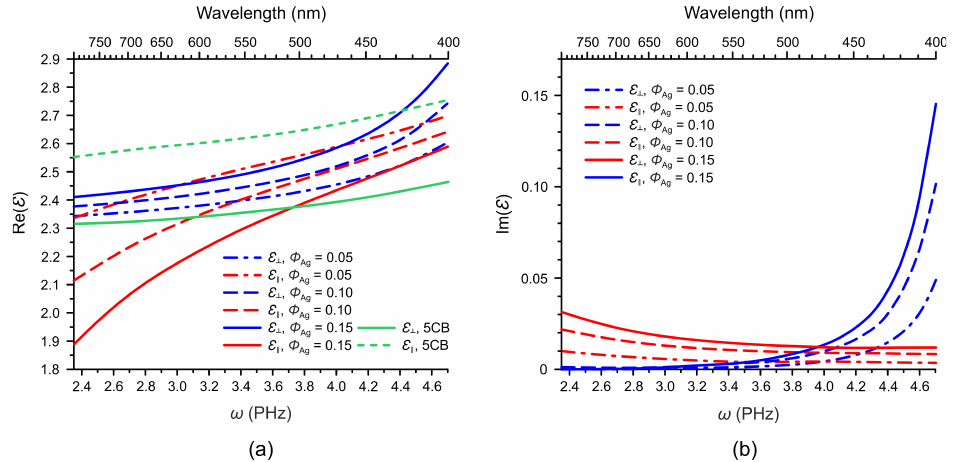
Figure 3. Real ( a ) and imaginary ( b ) parts of the transverse and longitudinal components of the high-frequency dielectric susceptibility of the 5CB nematic nano-composites for different values of the volume fractions of AgNPs.